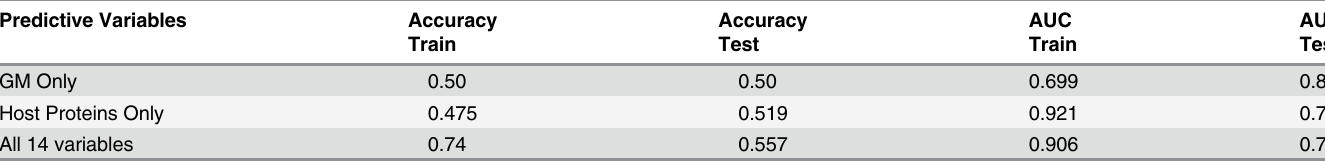
Table 7. Comparison of variable performance of GPS classifiers.